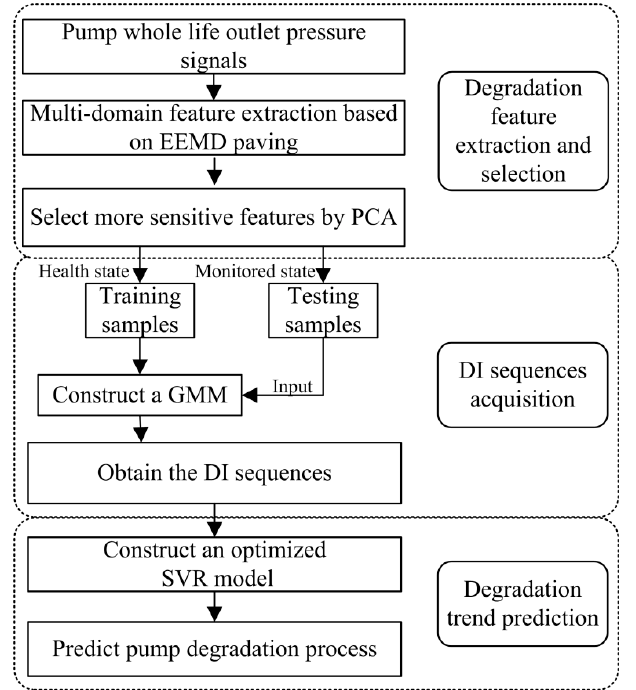
Figure 1. Framework of the proposed performance degradation prediction scheme.